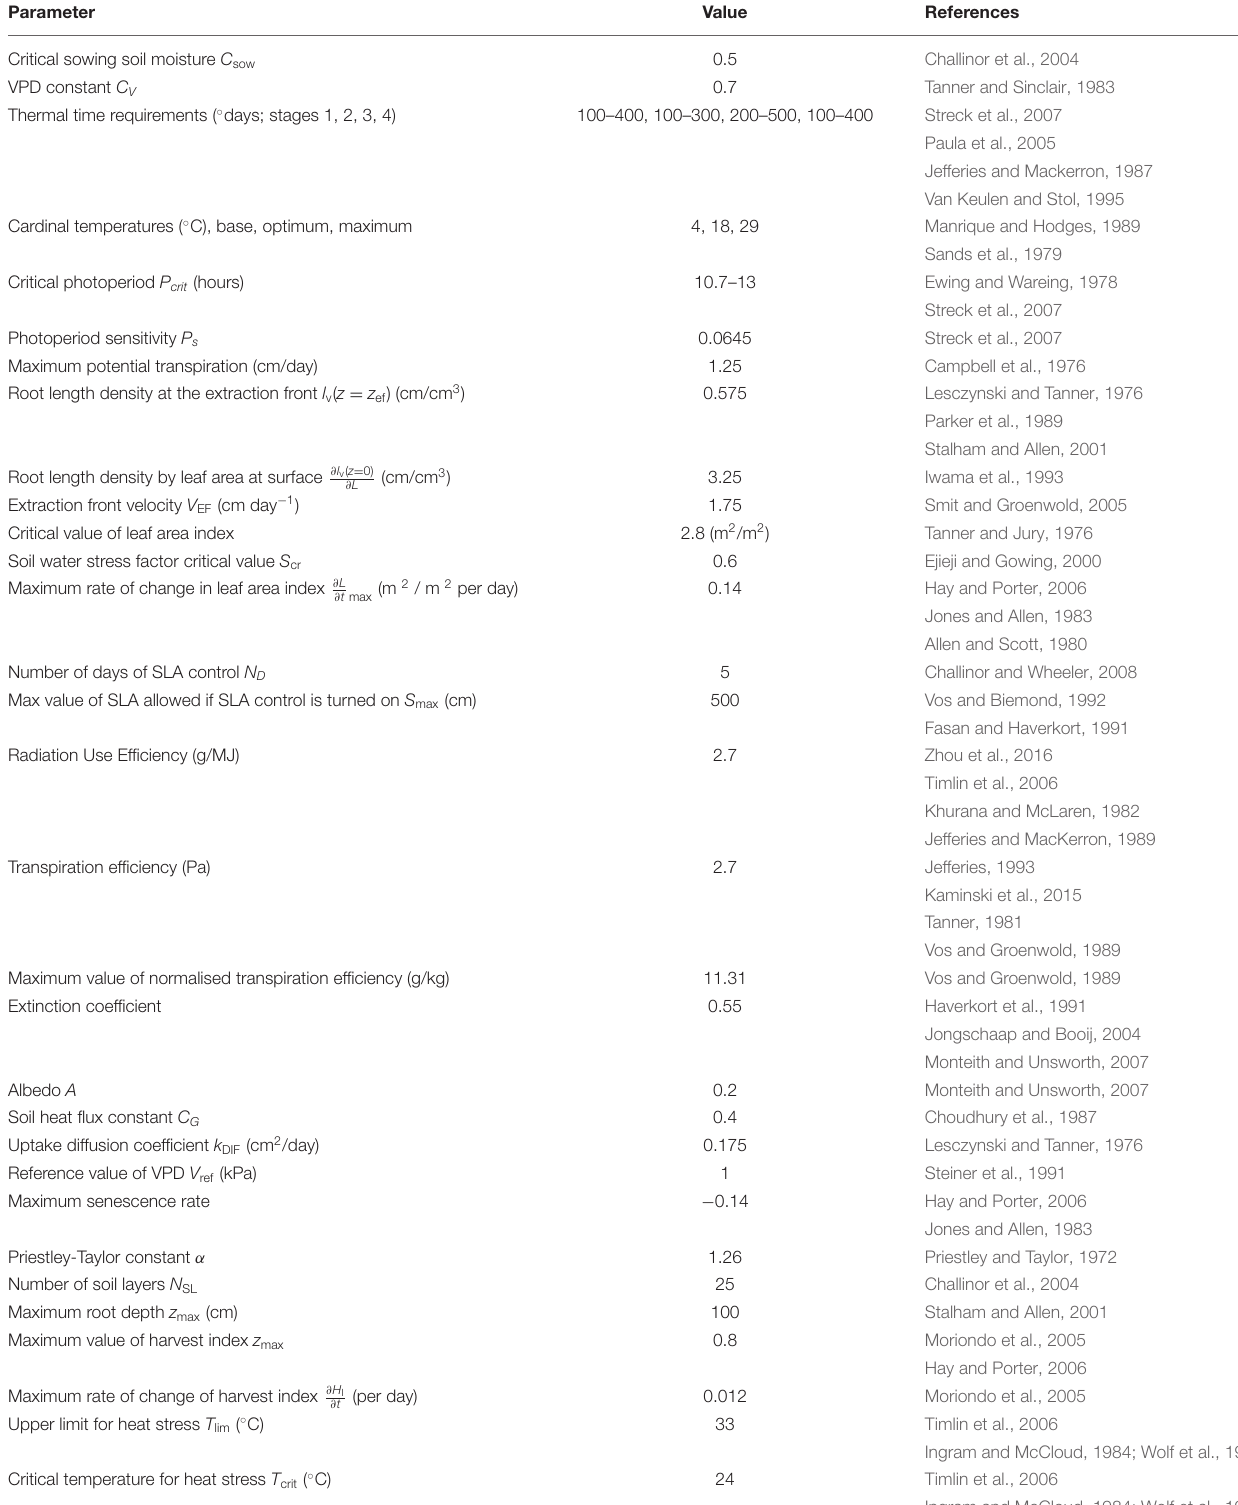
TABLE 2 | Parameters used in GLAM-potato, with ranges and units where applicable.